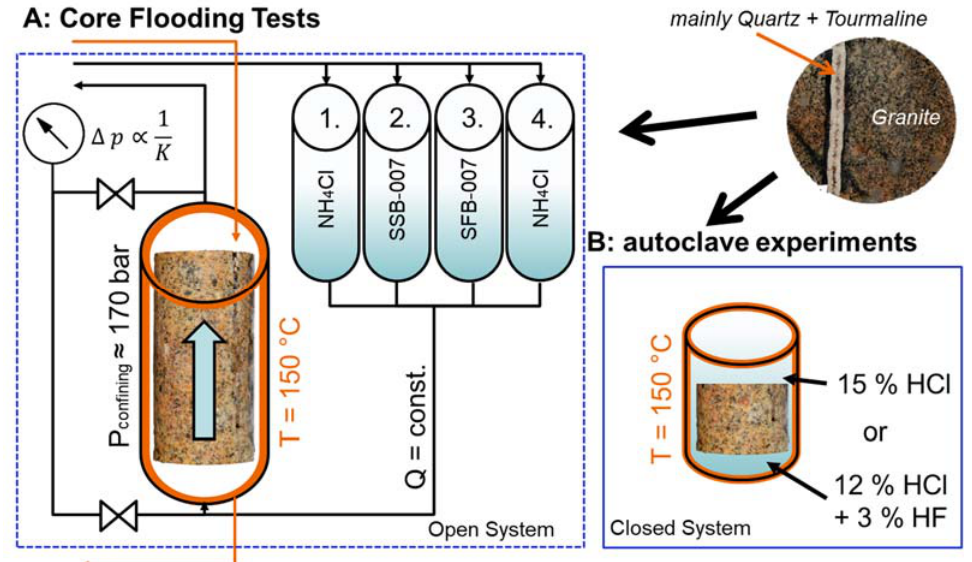
Figure 4. Simplified sketch of the setup and conditions of core flooding tests ( A ) and autoclave experiments ( B ).